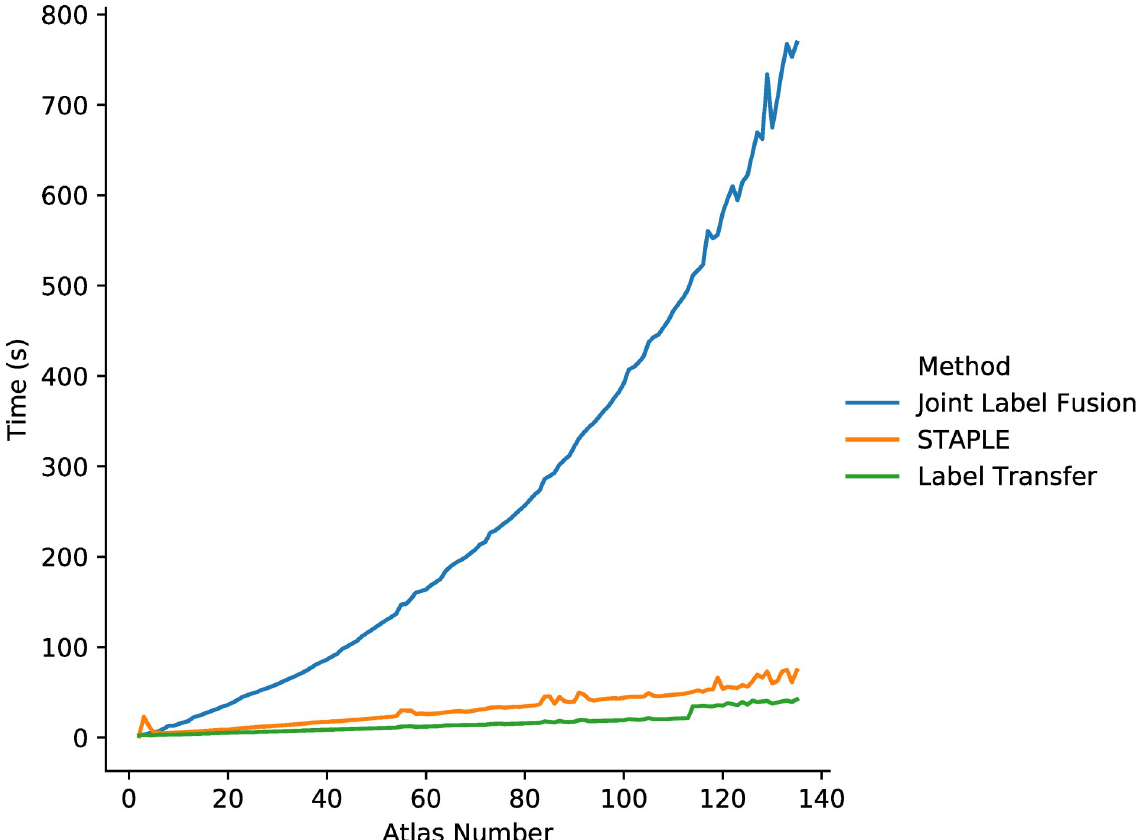
Fig 12. Average execution time of label fusion programs with the number of atlas selection ranging from 1 to 135. Three label fusion methods are Joint Label Fusion (top), STAPLE (middle) and the label transfer (bottom, our method).